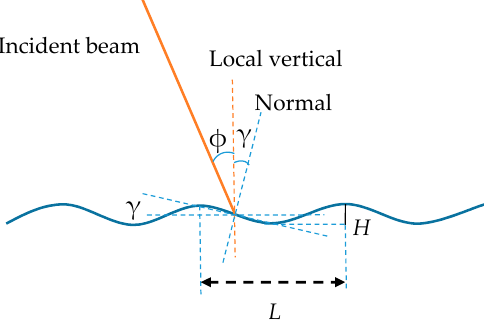
Figure 6. Wave effect on the incident angle of the laser beam. ϕ is the beam scanning angle, γ is the wave slope, H is the wave height, and L is the wavelength. Table 8. Wind speed and the parameters of its resulting waves.